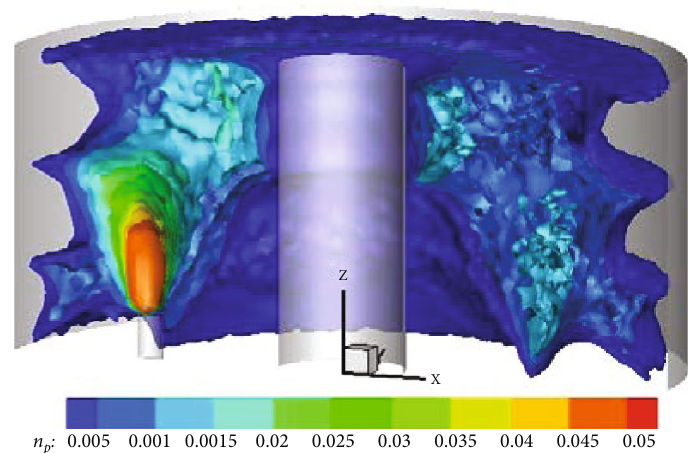
Figure 9: Distribution of primary electron density without the collision